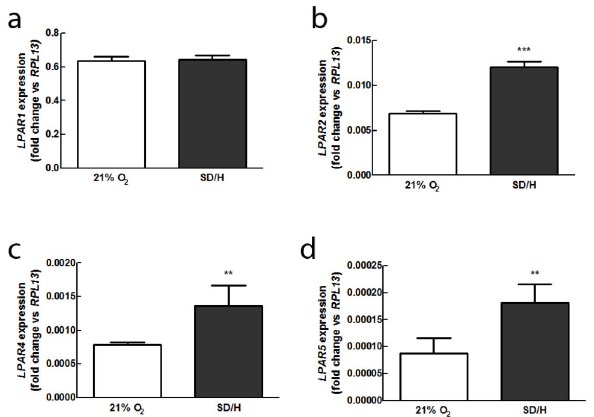
Figure 1. LPA receptor expression in human ASC is dependent on oxygen